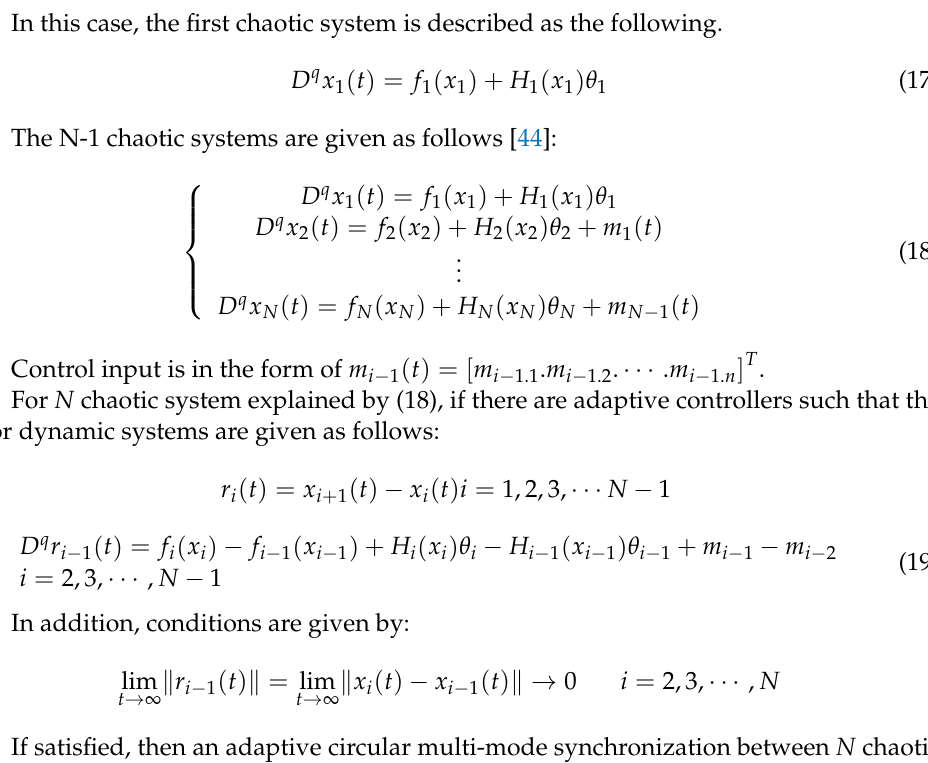
Figure 2. Circular multi-mode synchronizations.